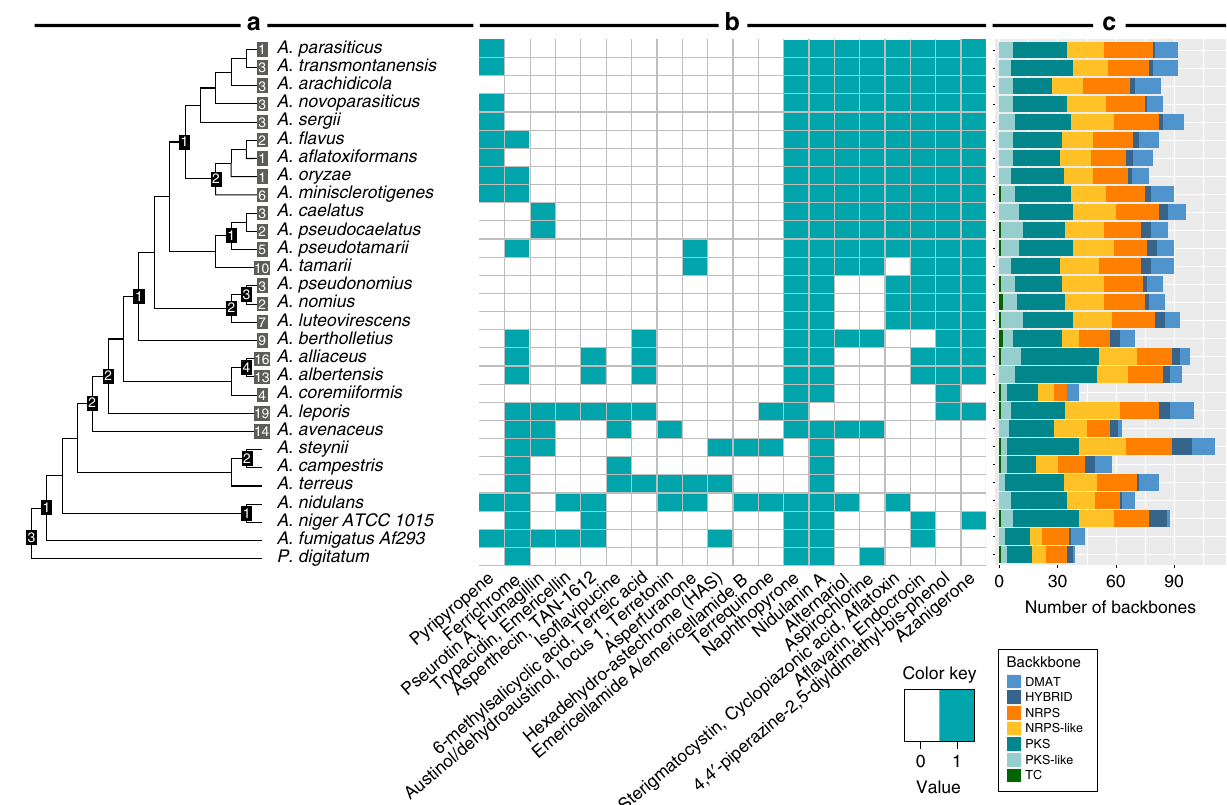
Fig. 6 Dereplication of known compounds and predicted secondary metabolite backbone genes per species. a A dendrogram representing the phylogenetic relationship between the species. The black boxes in the nodes represent the secondary metabolite gene cluster (SMGC) families shared among the species branching from that node. If there is no black box there are zero clusters shared. The gray boxes at the tips show the number of unique SMGC families only found in one species for the Flavi section. b Matrix indicating the presence and absence of SMGC families coupled to known clusters from the MIBiG database 66 for each species. Overview of the cluster family for a fl atoxin can be found in Supplementary Figure 11. c Predicted secondary metabolite genes for each species divided by the backbone enzyme. DMAT: dimethylallyltransferase (prenyl transferases), HYBRID: a backbone gene containing domains from NRPS and PKS backbones, NRPS: non-ribosomal peptide synthetase, NRPS-like: non-ribosomal peptide synthetase like, containing at least two NRPS-speci fi c domains and another domain or one NRPS A domain in combination with NAD binding 4 domain or short-chain